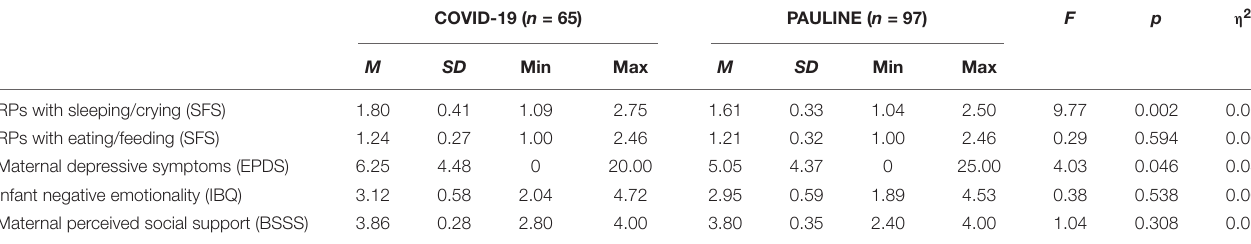
TABLE 2 | Descriptive statistics of the included psychometric variables for the main analyses. COVID-19 ( n = 65) PAULINE ( n = 97)